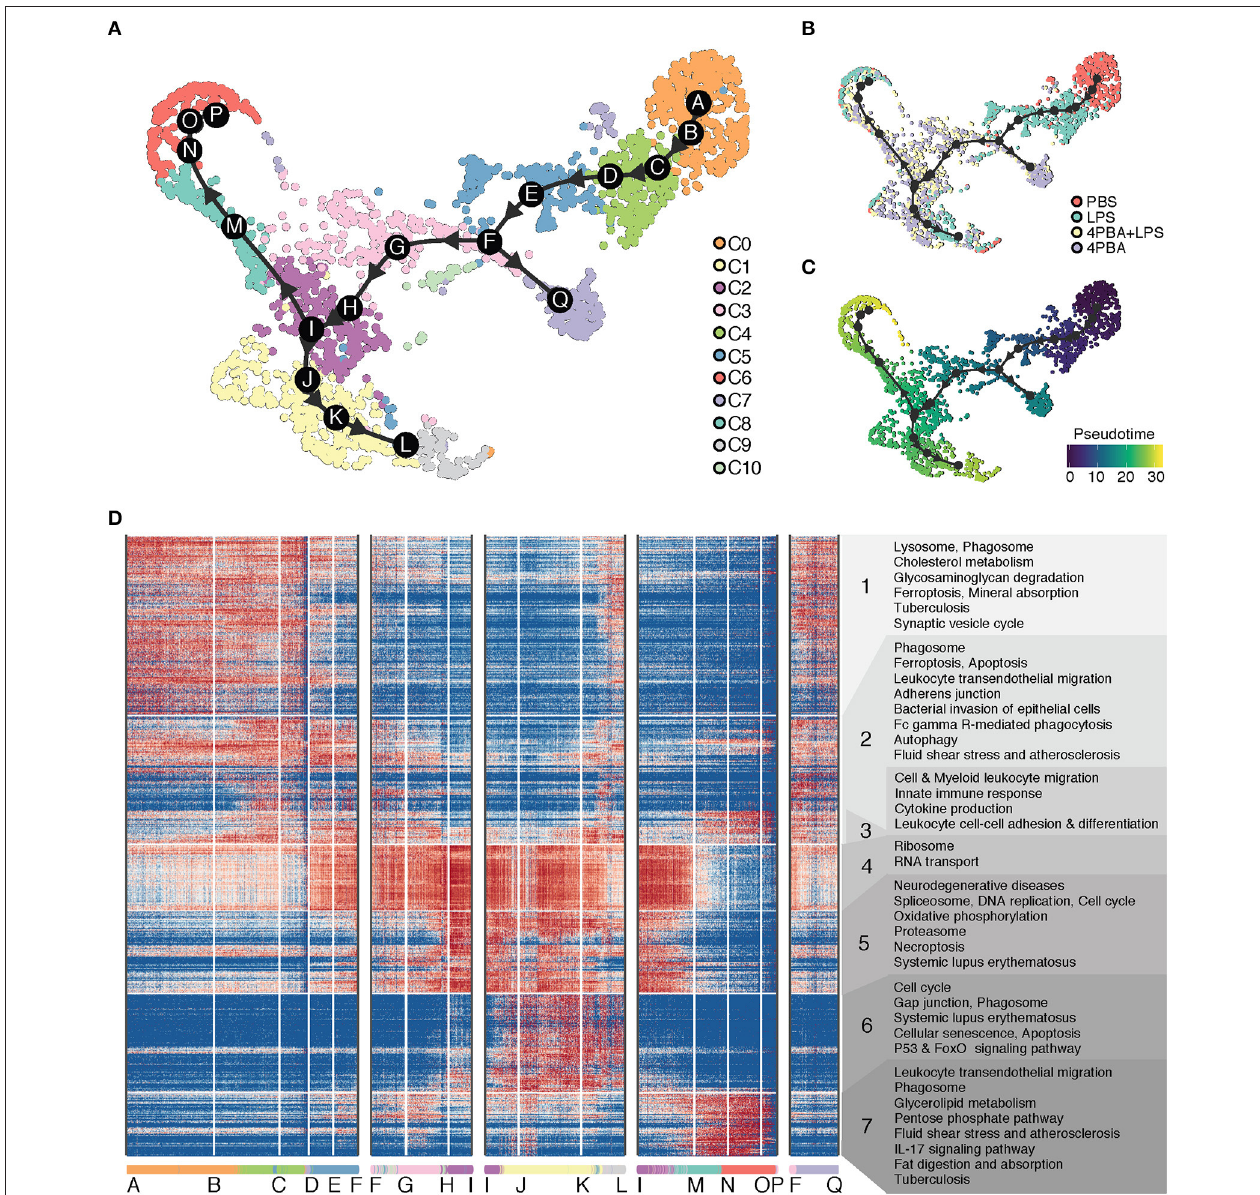
FIGURE 4 | Trajectory analysis of scRNA-seq data. (A) Inferred trajectory of cellular transitions along 17 milestones (A–Q) on the clustering map. There are five trajectory branches: milestones A-to-F; F-to-I; I-to-L; I-to-P; and F-to-Q. A legend on the right denotes 11 clusters (C0–C10) with different color codes. (B) Inferred trajectory on the sample map with control and treatments. A legend on the right denotes four samples (PBS, LPS, LPS + 4PBA, 4PBA) with different color codes. (C) Inferred trajectory on a pseudo time map. A starting cell was defined from a cell treated with PBS and in C0. (D) Gene expression profile and enriched functional annotation of 936 predictive genes that change expression level along trajectory branches. The predictive genes were clustered and visualized in a heatmap. The heatmap was split into 7 classes with functional terms on the right side. Cells from 11 clusters are sorted along the trajectory and 17 milestones are marked on the bottom of the